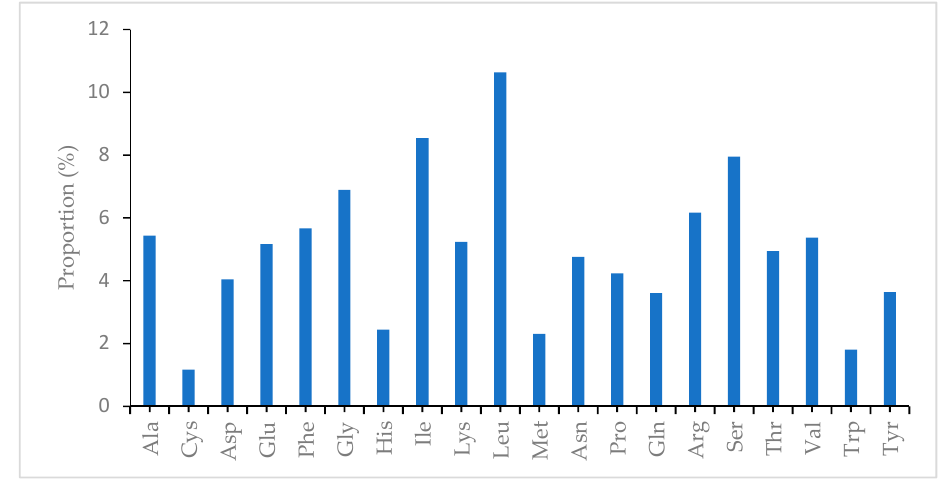
Figure 2. Amino acid frequencies in A. fruticosum chloroplast genome protein-coding sequences.